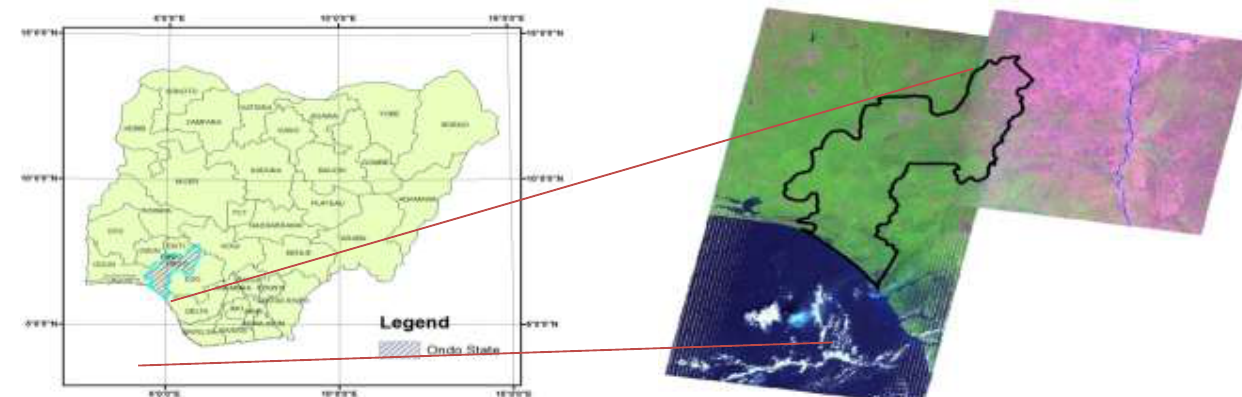
Figure 1. Study site location (red polygon) in the south-west of Nigeria (black polygon in the map). In the right map, the Administrative boundary of the study area on a mosaicked Landsat 7 ETM+ (path/row-189/055, 190/055, 190/056, composition RGB-543